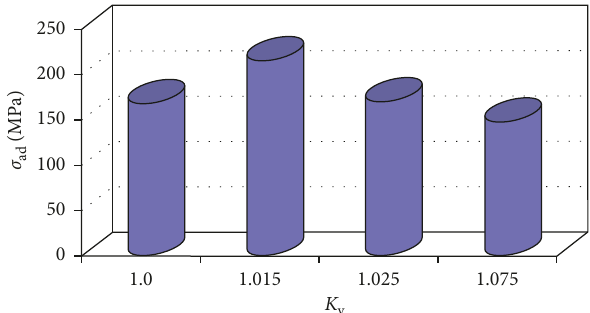
Figure 21: The adhesion strength of the welded